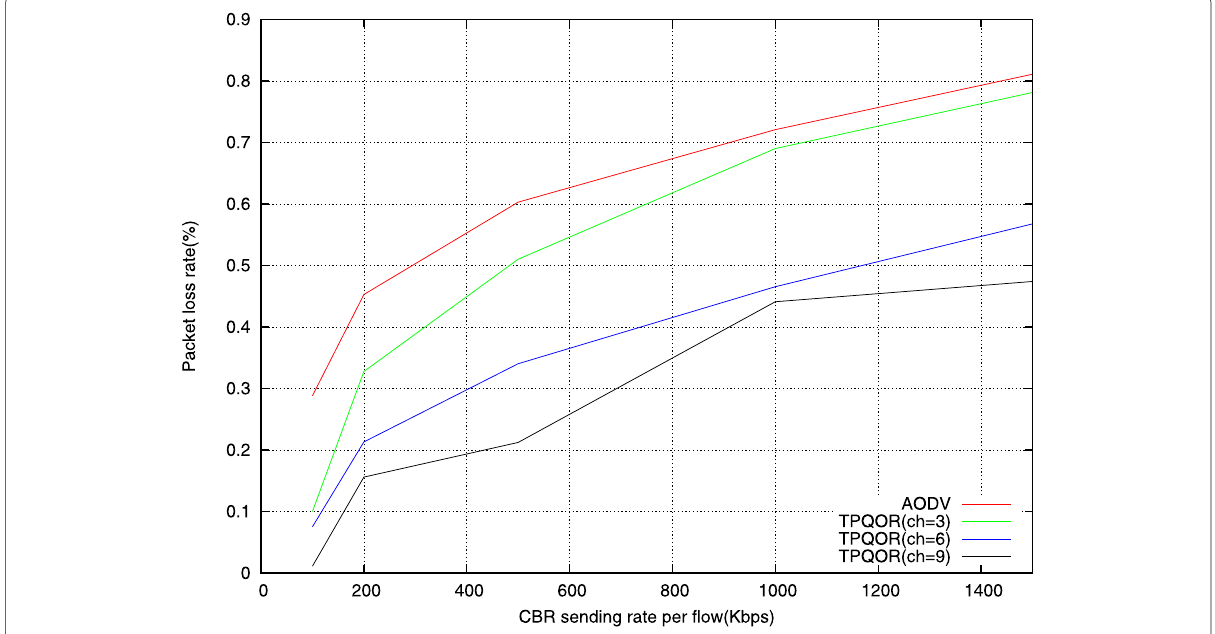
the average network throughput of AODV protocol to TPQOR protocol with different number of channels at different loads. It shows that the average network through- put will increase when the transmission rate of CBR flows increases. The characteristic of multi-channel makes the network throughput of TPQOR protocol increase faster